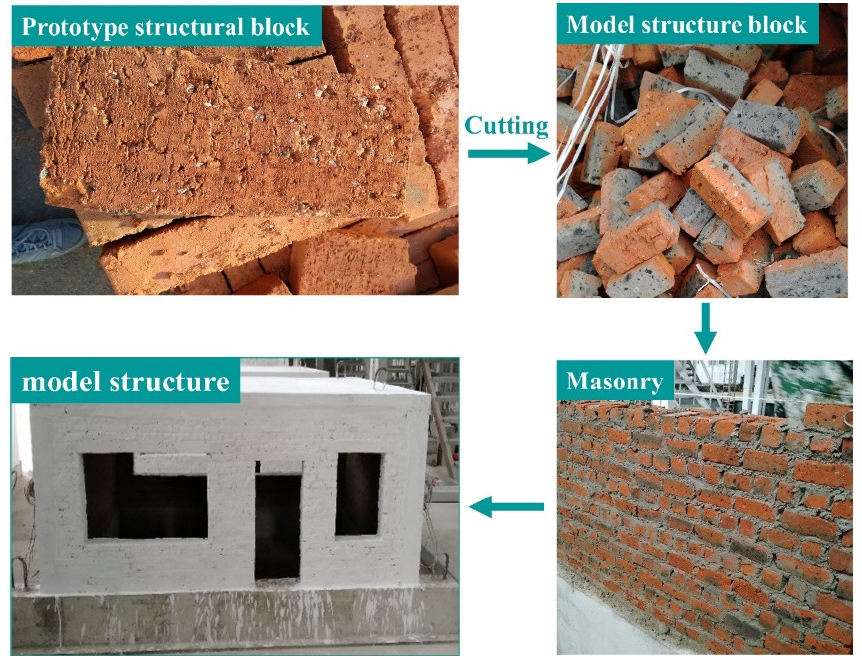
Figure 7. The production process of the structural model.